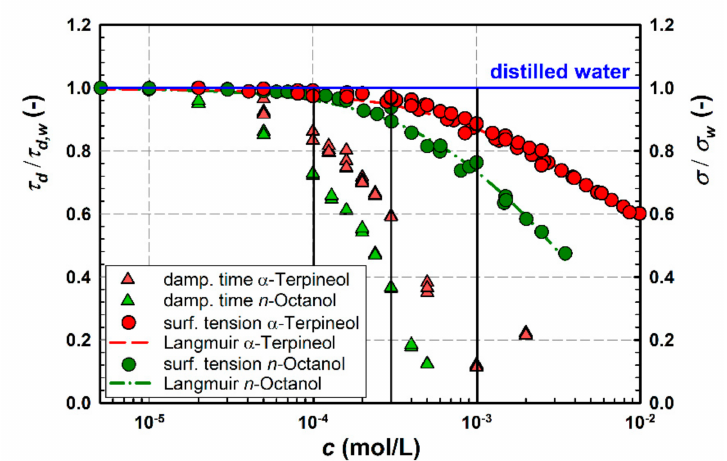
Figure 6. Relative decrease of the dimensionless damping time (triangles, left axis) and the relative decrease of surface tension (circles, right axis) in dependence on the surfactant concentration. The blue solid line represents the distilled water; black solid lines indicate the concentrations used for collision